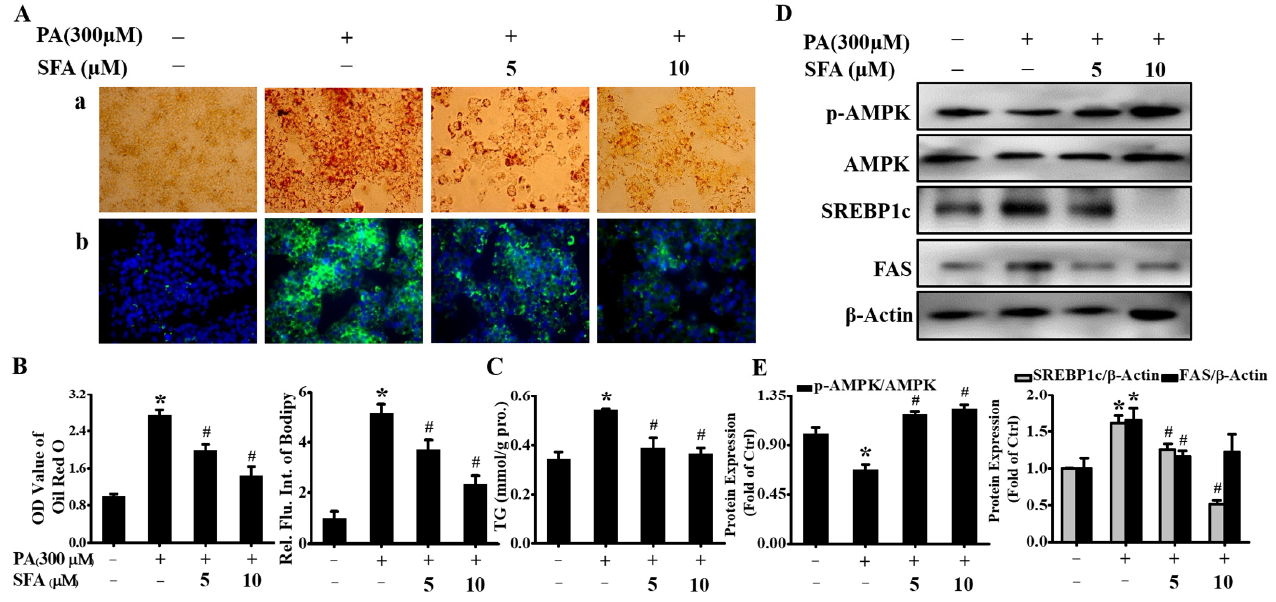
Figure 2. Effects of SFA on lipid accumulation and related protein expression in PA-stressed HepG2 cells: ( A ) evaluation of lipid accumulation by Oil red O staining ( a ) and BODIPY staining ( b ) after different concentrations of SFA treatments in the presence of 300 µM PA for 24 h; ( B ) quantitative analysis of lipid accumulation based on the imaging in ( A ) by colorimetric assays; ( C ) the measure- ment of TG contents (mmol/g protein) with different treatments. Western blot analysis showed the expressions of phosphorylated AMPK, total AMPK, SREBP1cm and FAS ( D ), and gray analysis of each band ( E ). All values are expressed as means ± SD from three independent determinations, * p < 0.05 vs. control cells: # p < 0.05 vs. only PA-stressed HepG2 cells.